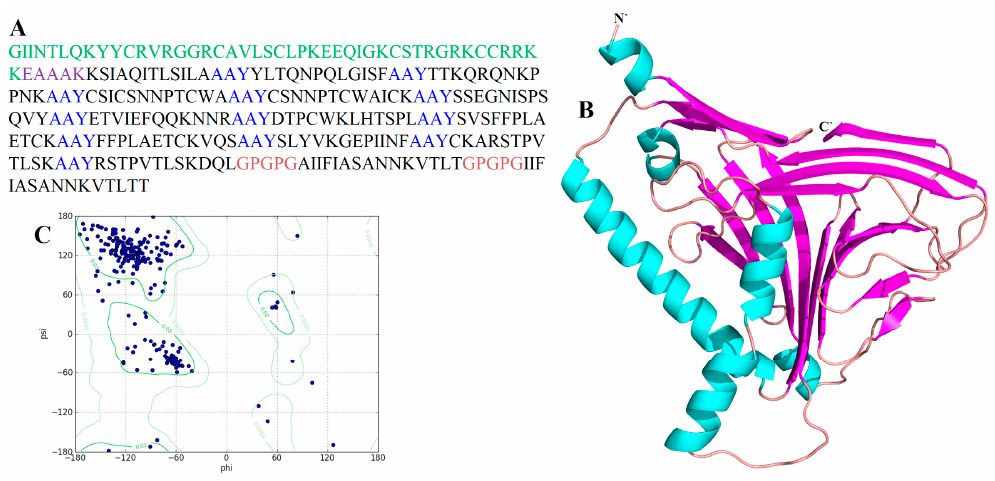
Figure 5. Three-dimensional (3D) structure prediction and validation of MEV construct: ( A ) MEV construct sequence. Epitopes sequence is in black. The adjuvant sequence is highlighted in green color, EAAAK linker sequence is highlighted in purple, AAY linkers are highlighted with blue, and GPGPG linkers are highlighted with pink; ( B ) MEV construct refined 3D structure (alpha helix: cyan color; beta strands: pink color and loops: brown color); ( C ) Ramachandran plot analysis of predicted structure where 97.7% of residues present in the most favored region.